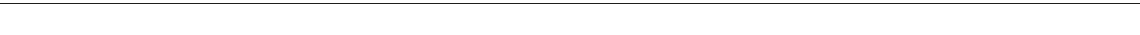
Fig. 5 Regulation of lipid and glucose metabolism by MKRN1 and AMPK. a , b Relative proportions of DEGs in MKRN1 -null liver and adipose tissues according to their associated GOBPs. The GOBP terms at level 1 ( a ) and levels 2 – 4 ( b ) were used for general cellular processes and metabolic processes, respectively. c Cellular processes related to lipid and carbohydrate metabolism enriched by the up- and downregulated genes identi fi ed in MKRN1 -null liver or adipose tissue. The bars represent − log 10 ( P -value), where the P -value is the signi fi cance of the processes being enriched by the up- or downregulated genes. d Heat maps showing the changes in the expression of DEGs involved in fatty acid biosynthesis and β -oxidation, gluconeogenesis and thermogenesis. The colour bar shows the gradient of the log 2 fold changes of mRNA expression levels in MKRN1-depleted samples relative to those in WT samples. e , f Network models describing alterations of metabolic reactions regulated by DEGs in MKRN1 -null livers ( e ) and adipose tissue ( f ). Arrows denote metabolic reactions, and dotted lines denote the transportation of molecules or regulation involving intermediate regulators between the linked molecules. Node colours represent up- (red) or downregulation (green) in MKRN1 -null livers or adipose tissue. The colour bar represents the gradient of the log 2 fold changes of mRNA expression levels induced by MKRN1 ablation relative to those in